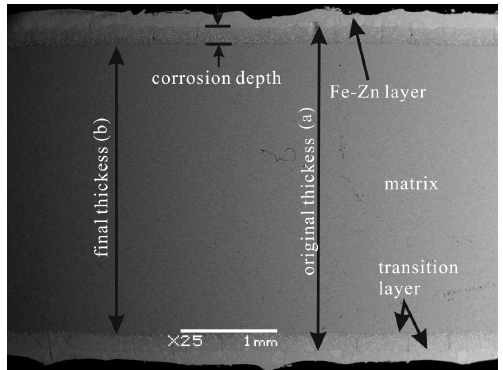
Figure 1. The schematic of specimen thickness measurement.